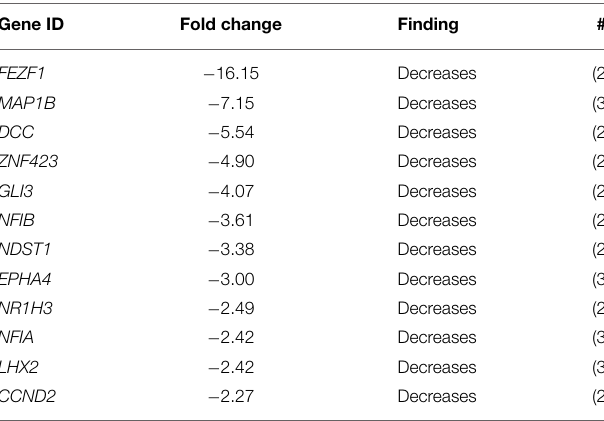
TABLE 5C | All genes predicting an increase in morphology of CNS between GD90 and